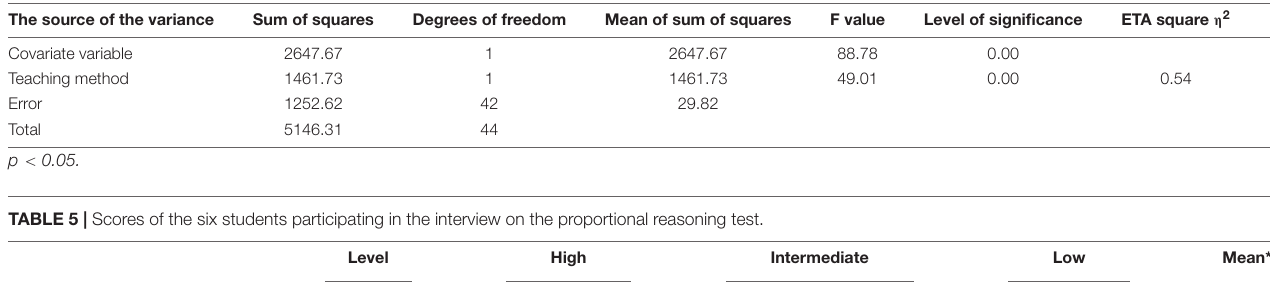
TABLE 4 | Findings of the one-way ANCOVA.